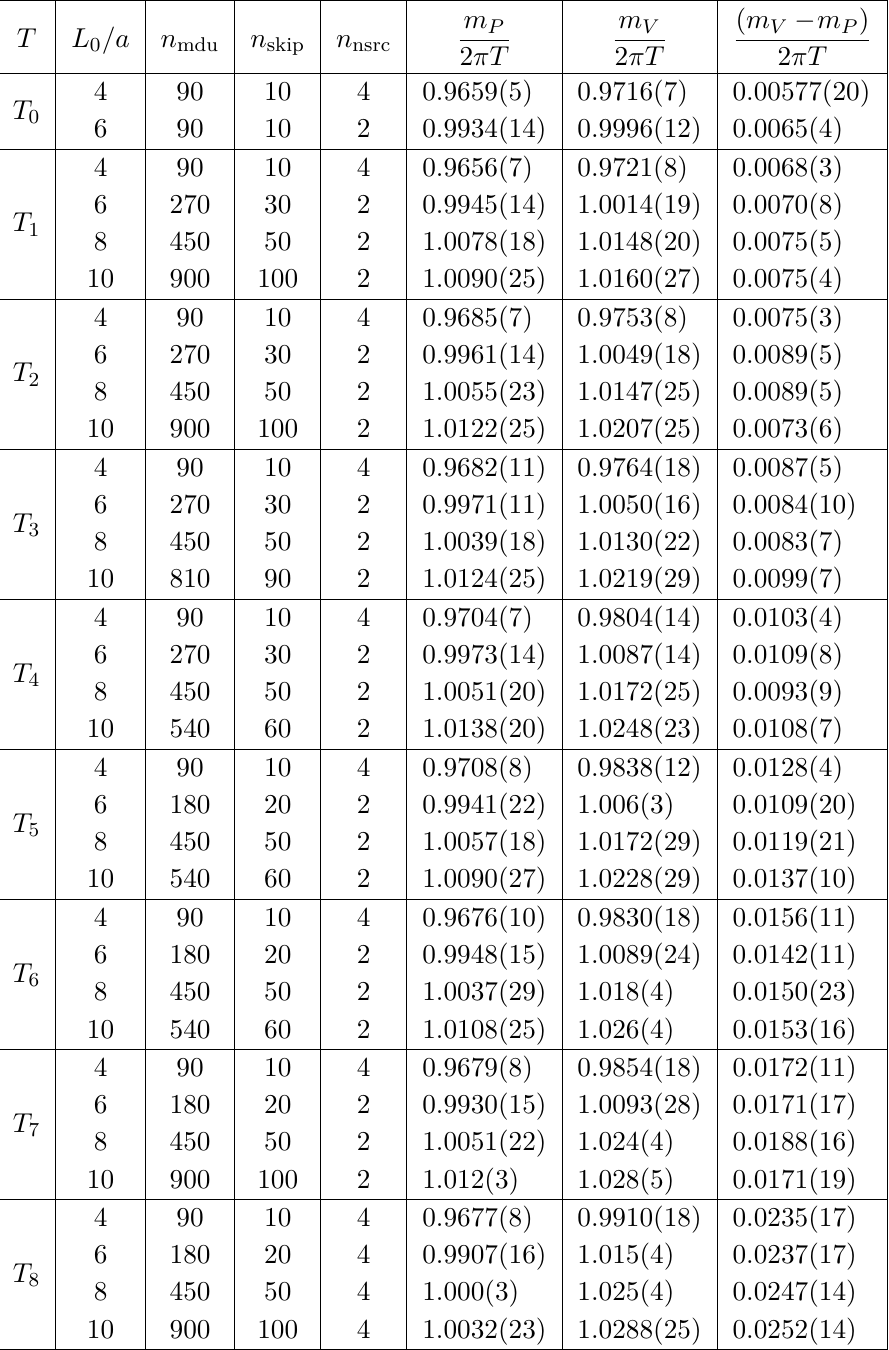
Table 8 . Results for the pseudoscalar, m P , and the vector, m V , non-singlet meson masses together with their difference ( m V − m P ) all normalized to 2 πT at finite lattice spacing for the temperatures T 0 , . . . , T 8 . The number of MDUs generated, n mdu , those skipped between two consecutive measure- ments, n skip , and the number of local sources per configuration on which the two-point correlation functions have been computed, n nsrc , are also